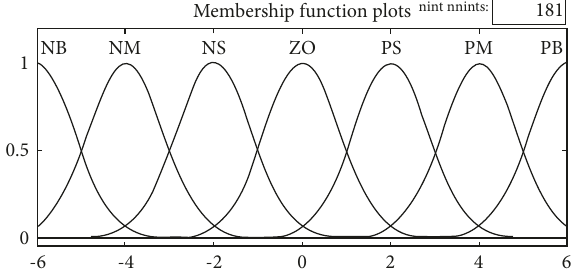
Figure 6: Input ∆ β membership function.